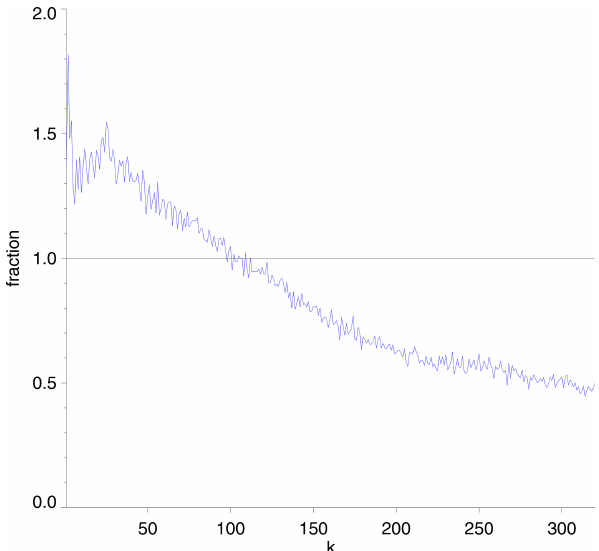
Figure 8. Fraction of the energy in IG modes in ERA5 relative to ICON as a function of zonal wave number (ERA5 divided by ICON).